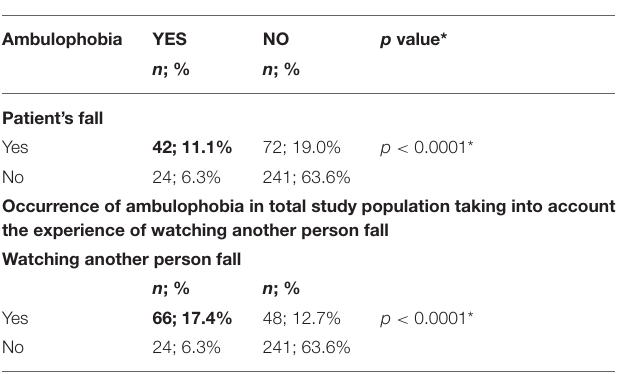
TABLE 4 | Occurrence of ambulophobia in the total study population including falls experienced by the patient themselves or seen by them. Occurrence of ambulophobia in total study population including experience of own